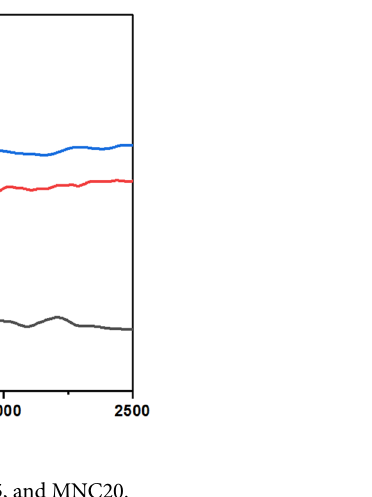
Figure 4. RAMAN spectra of MNC10, MNC15, and